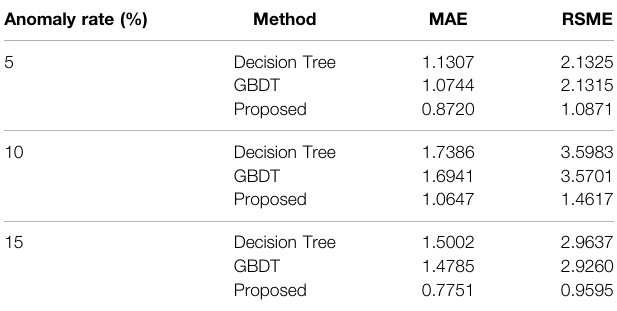
TABLE 4 | The results of the comparative analysis in different outliers detection method. Anomaly rate